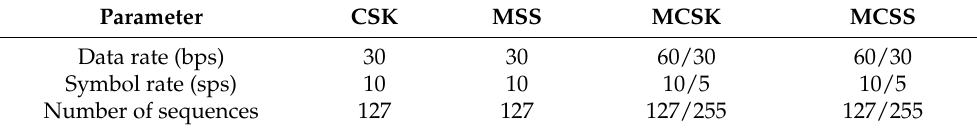
Table 2. Parameters based on the modulation scheme. Parameter CSK MSS MCSK